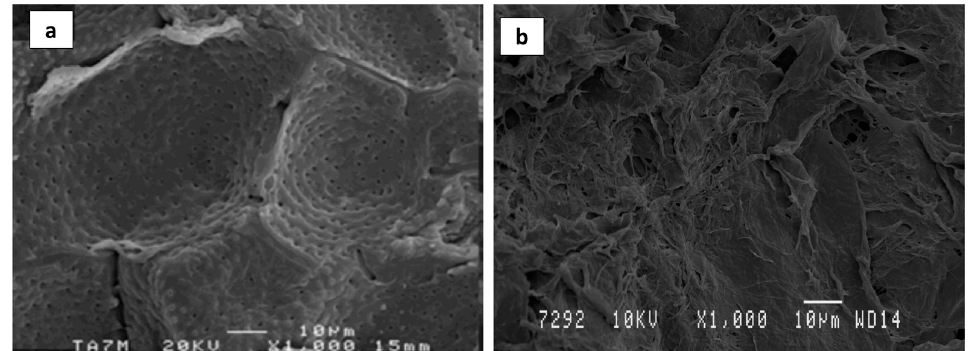
Figure 5. SEM micrographs of AS before ( a ) and after MAE under optimal conditions ( b ) at